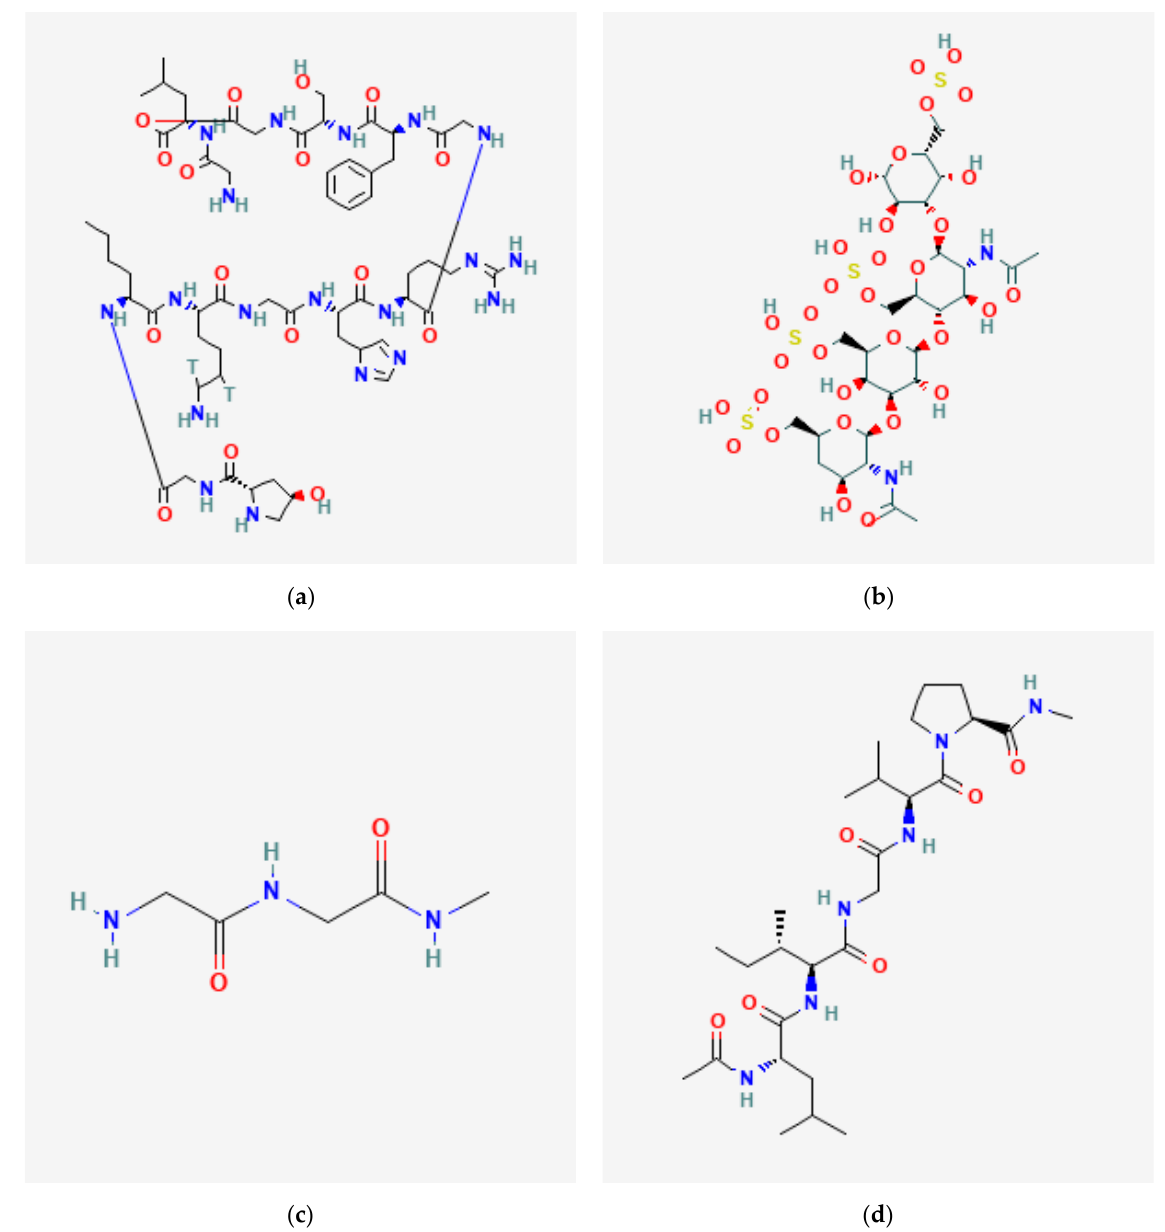
Figure 7. Molecular structure of some protein molecules: ( a ) collagen I [175]; ( b ) keratin [176]; ( c ) fibrin [177] ; ( d ) elastin [178].